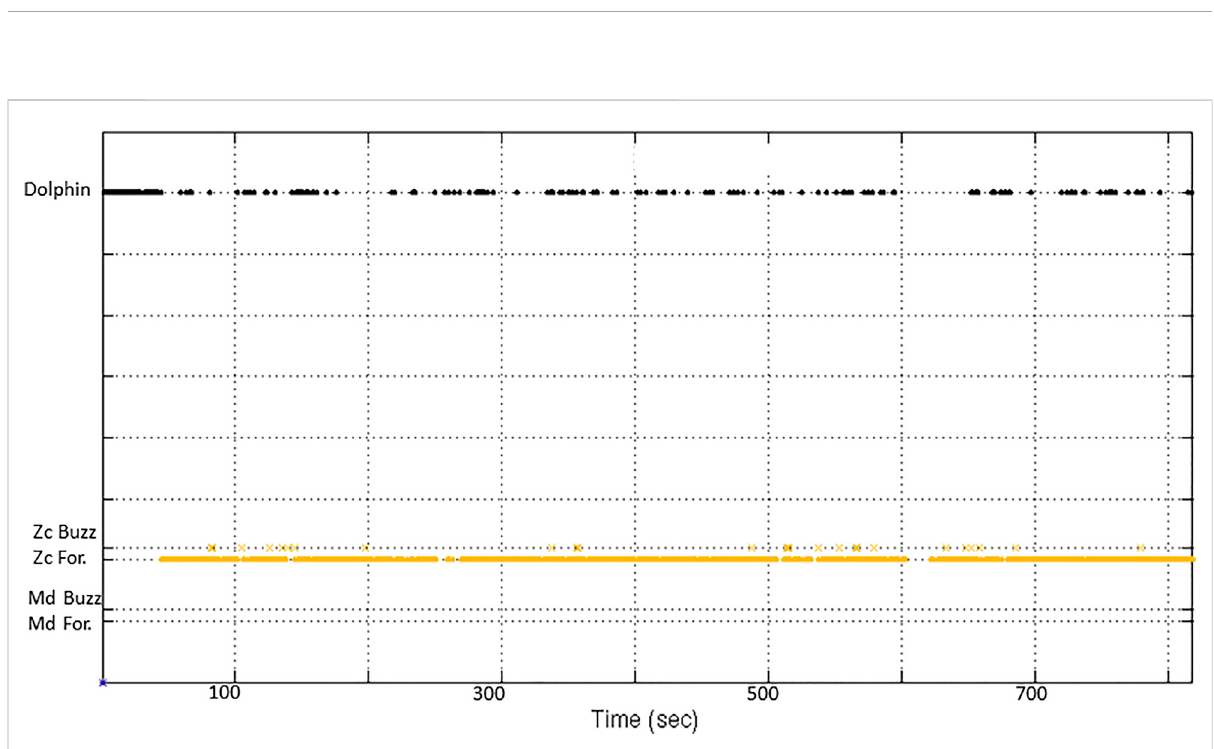
FIGURE 5 Output of CS-SVM classi fi er versus time for SOAR hydrophone 908. Orange dots are Zc foraging click detections and orange x ’ s are Zc buzz click detections. Black dots are generalized dolphin click